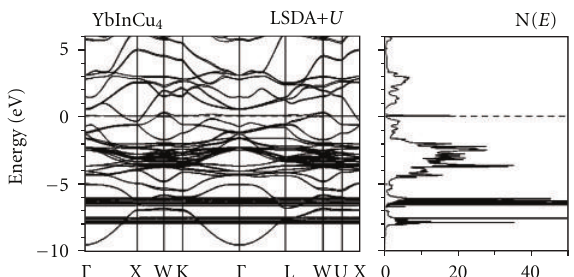
Figure 95: LSDA+ U self-consistent fully relativistic, spin-polarized energy band structure and total DOS (in states/(unit cell eV)) of YbInCu 4 ( U e ff = 6eV)